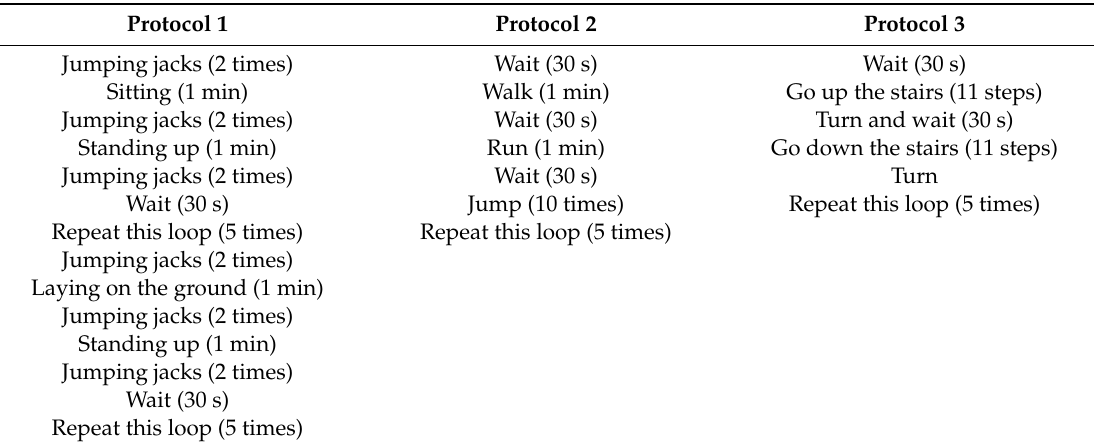
Table 2. Three performed